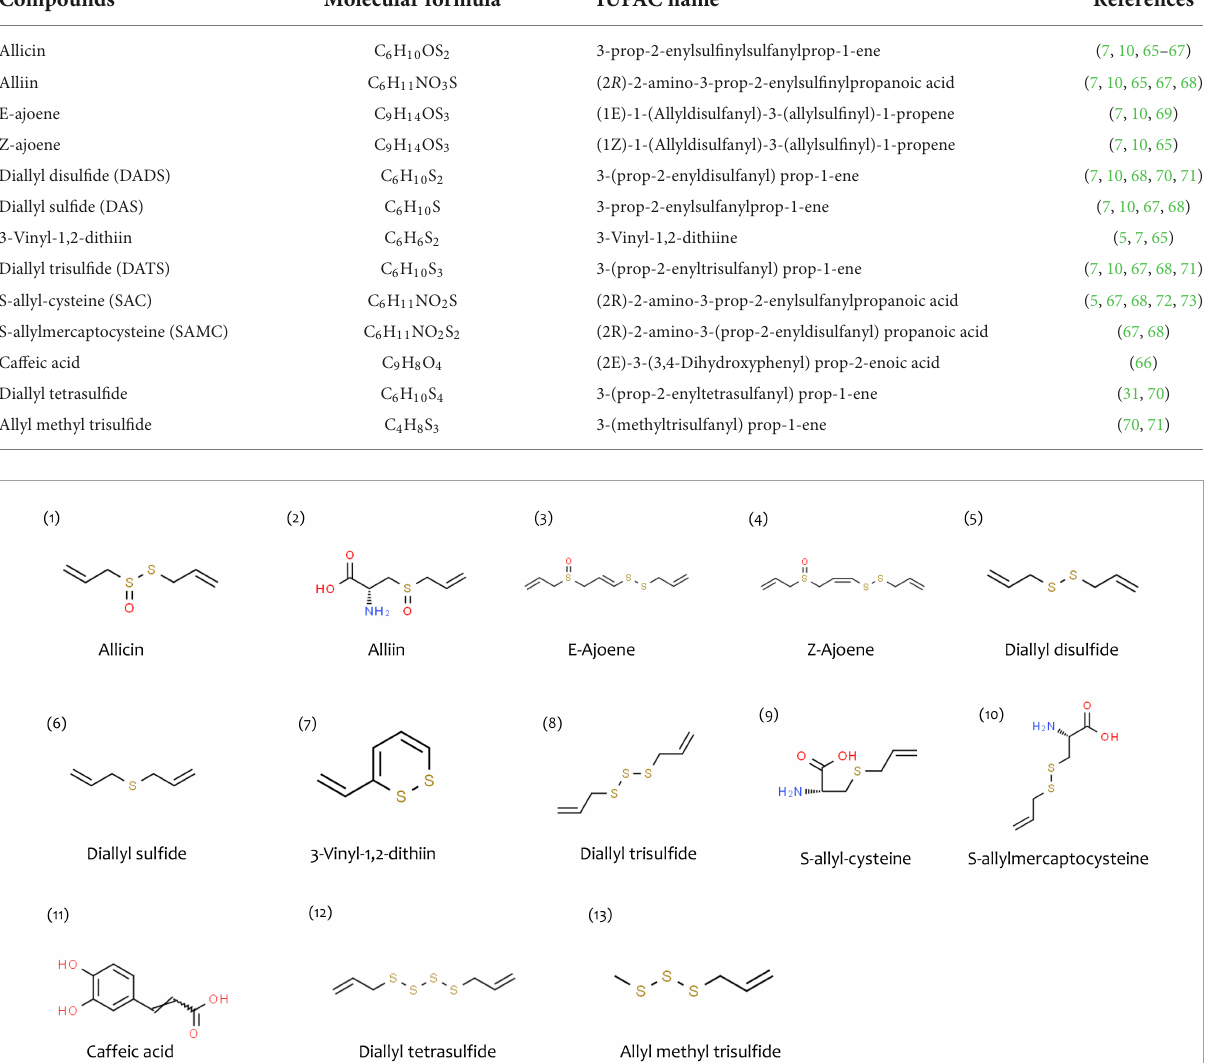
TABLE 1 Phytochemistry of A. sativum.